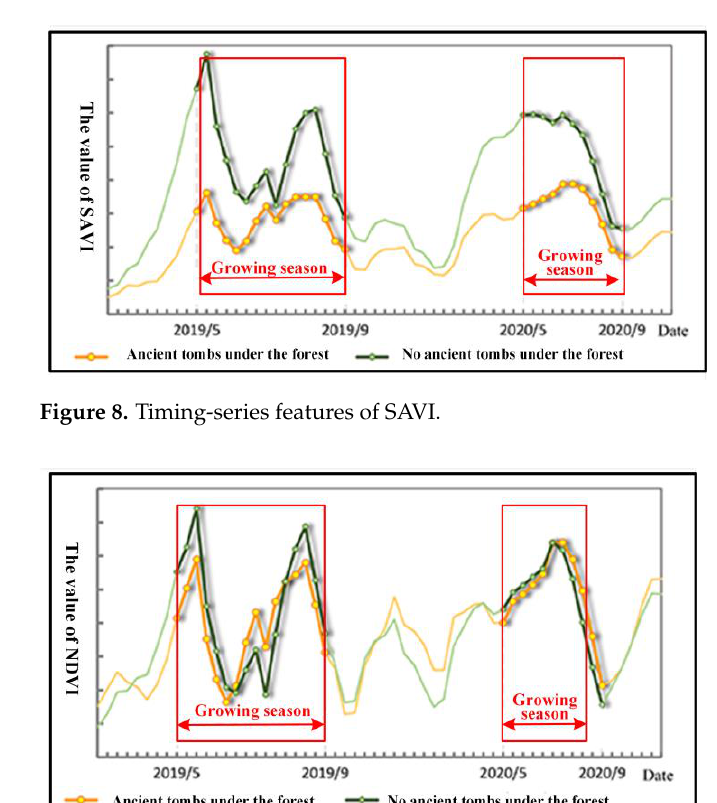
Figure 7. Timing-series features of EVI.